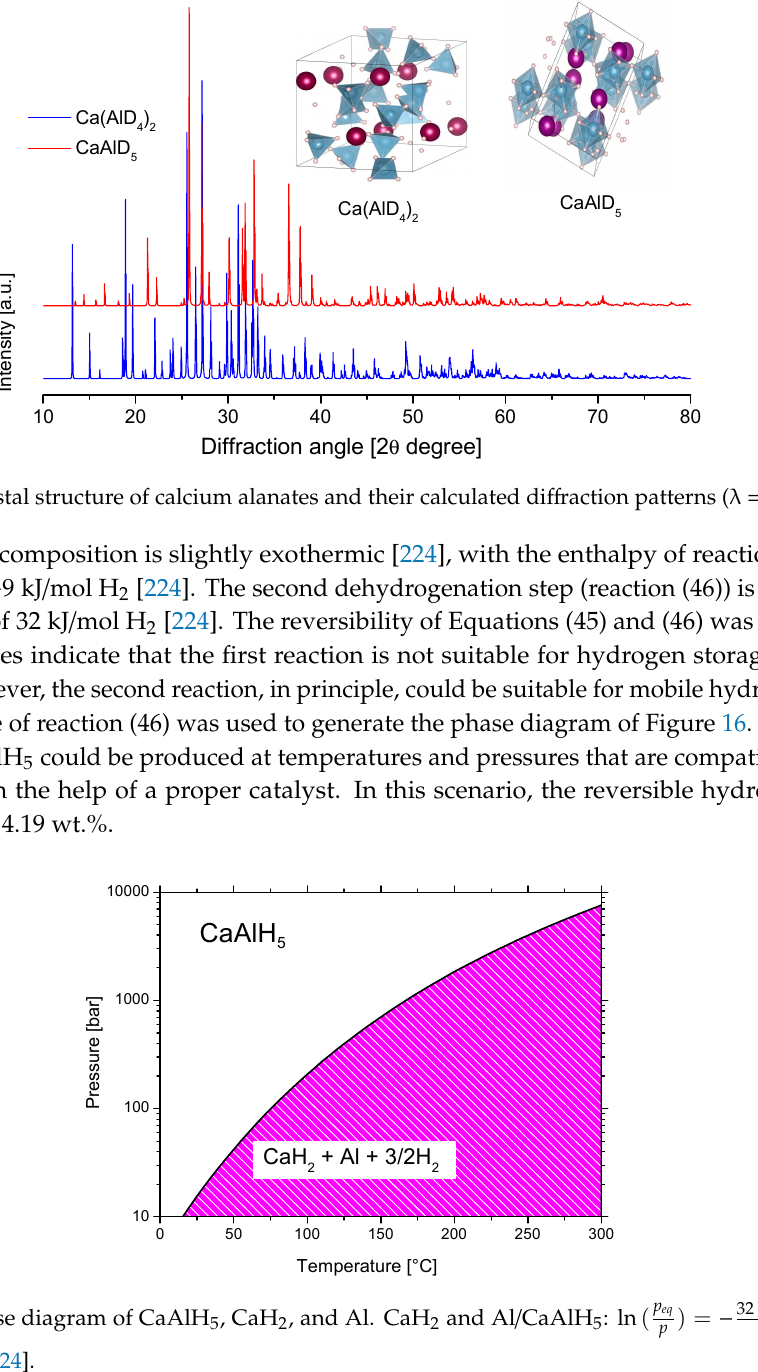
Figure 16. Phase diagram of CaAlH 5 , CaH 2 , and Al. CaH 2 and Al / CaAlH 5 : ln ( 130 J · mol − 1 K − 1 (cid:2869)(cid:2871)(cid:2868)(cid:3011)·(cid:3040)(cid:3042)(cid:3039) (cid:3127)(cid:3117) (cid:3012) (cid:3127)(cid:3117) R